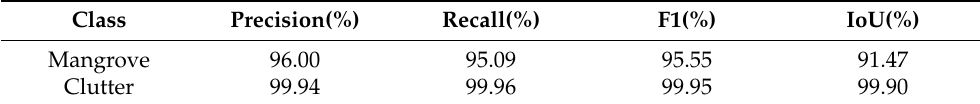
Table 4. The performance for the trained model on a new dataset.